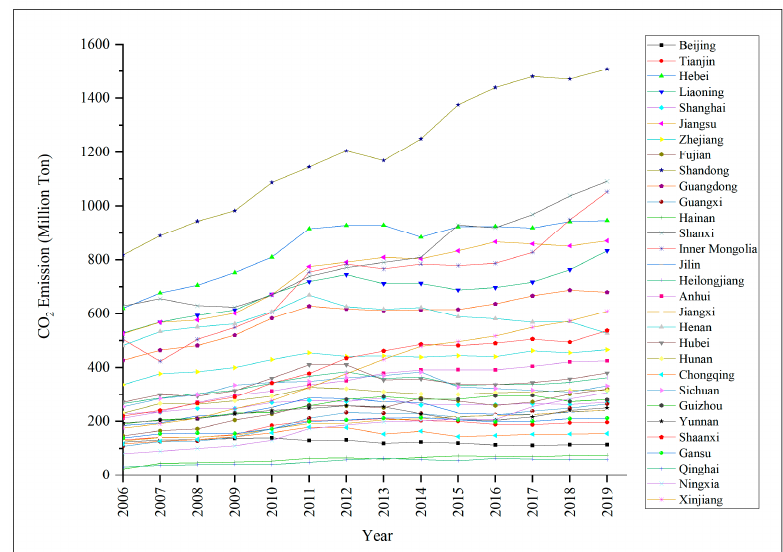
Figure 3. CO 2 emissions for 30 provinces in China from 2006 to 2019.